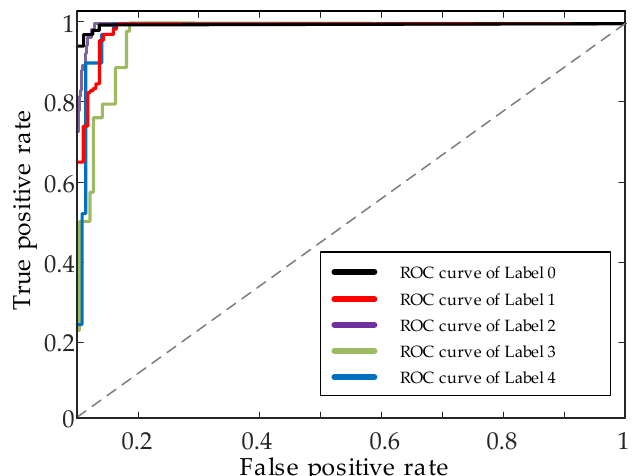
Figure 11. ROC curves for different labels.